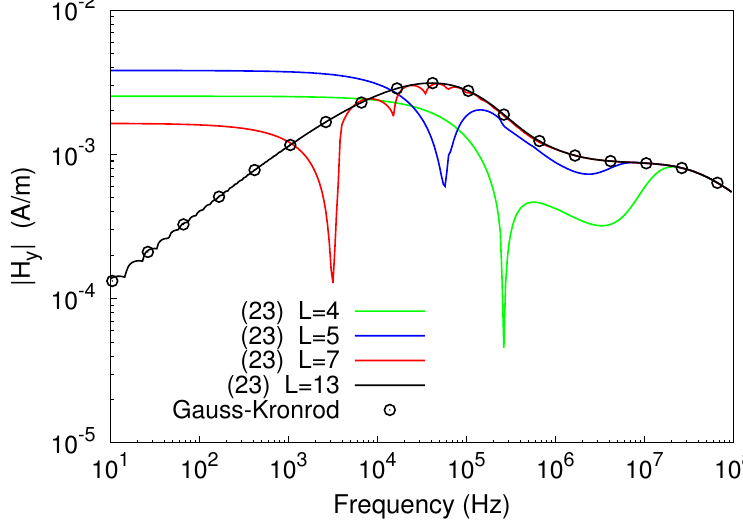
Figure 7. Amplitude-frequency spectrum of H y , resulting from using both (23) and the G7-K15